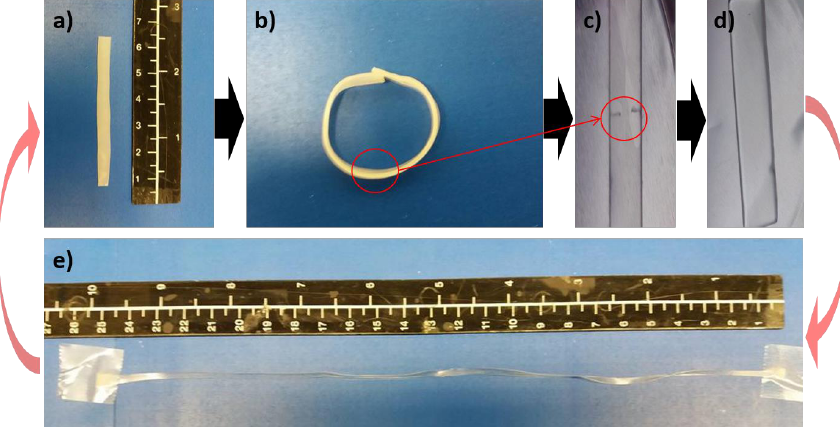
Figure 7. Series of images for cPCL 40 -L 60 : ( a ) pristine specimen; ( b ) bending experiment and ( c ) recovery to the original flat shape by heating above T m (healing temperature); ( d ) self-healing capability enables closure of the damages; ( e ) reprogrammability of the sample via stretching to ~250%, and finally recovering to the original shape.